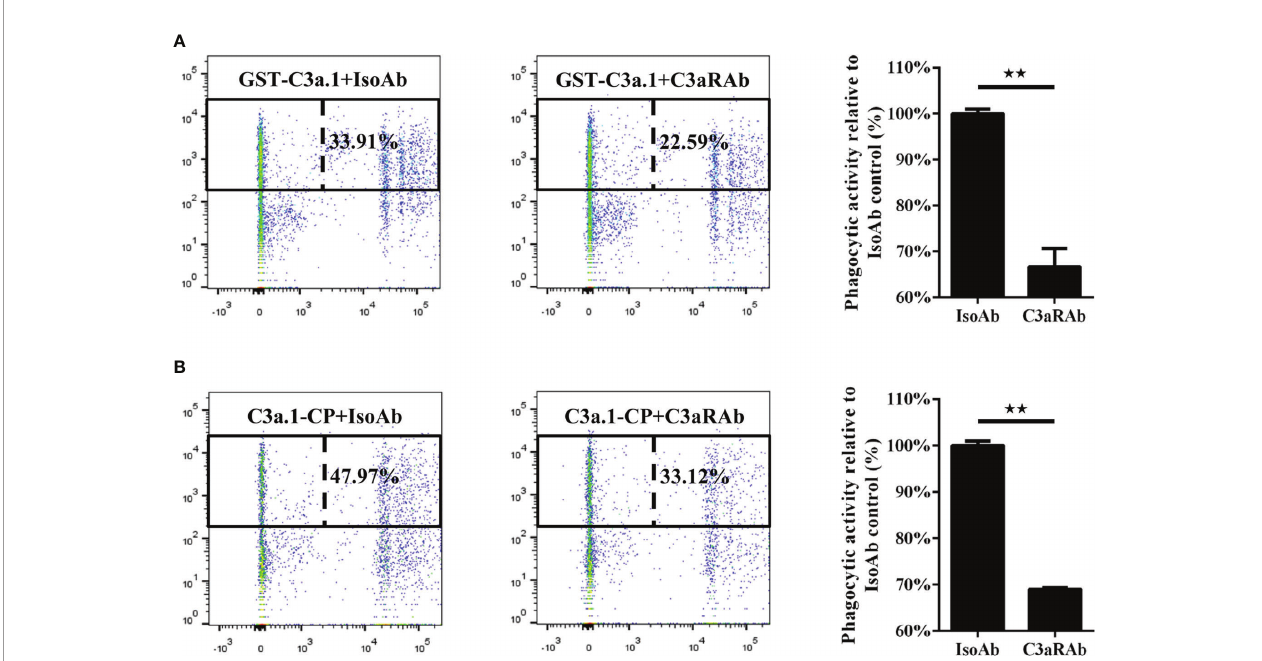
FIGURE 9 | Anti-C3aR pAbs inhibits the phagocytosis-stimulating activity of C3a.1 to grass carp IgM + B cells. (A) Anti-C3aR pAbs inhibits the phagocytosis- stimulating activity of GST-C3a.1 to grass carp IgM + B cells. (B) Anti-C3aR pAbs inhibits the phagocytosis-stimulating activity of C3a.1-CP to grass carp IgM + B cells. HKLs were incubated with GST-C3a.1 or C3a.1-CP, anti-C3aR pAbs or isotype control Abs, as well as fl uorescent beads at 28°C for 2 h. Thereafter, the non- ingested beads in cell suspensions were removed, and the cells were stained with mouse anti-grass carp IgM mAbs. Finally, the phagocytic activity of grass